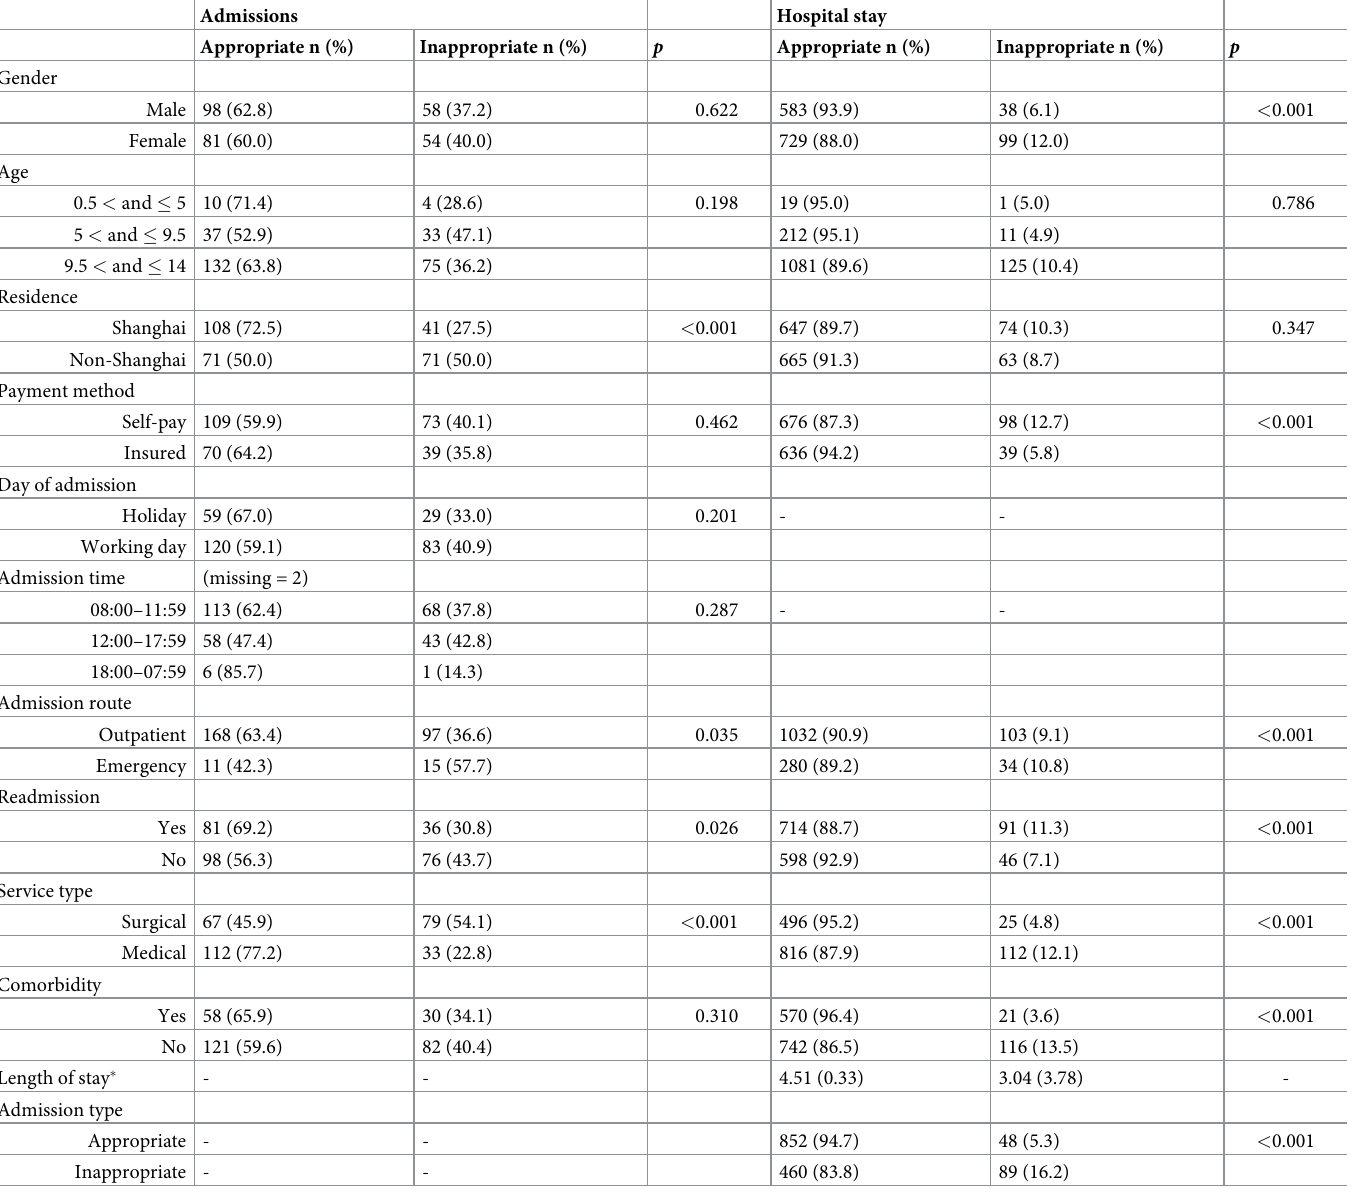
Table 1. Distribution of inappropriate admissions and hospital days by patients’